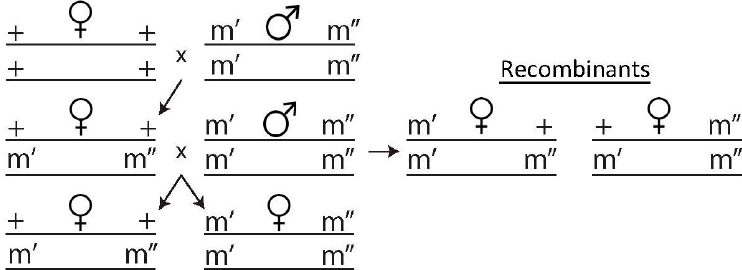
Figure 1. Schematic of fly crossing used to track recombination events. ++ refers to wild type and m’ m” refers to genetic markers on each chromosome ( y v on the X; vg bw on the 2nd; e ro on the 3rd). Recombination is tracked by looking at the ratio of recombinants to the total number of progeny produced.